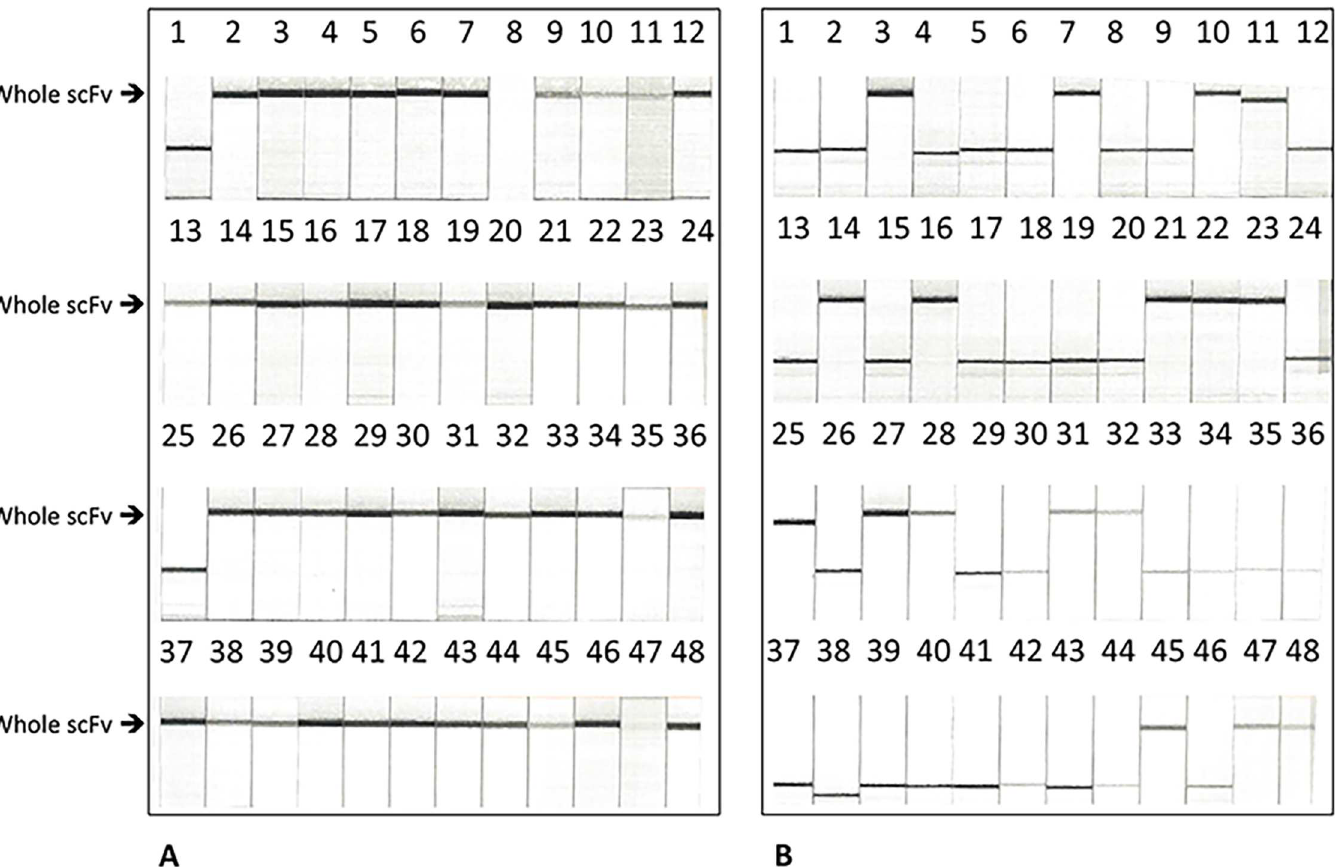
Fig 2. PCR analysisof scFv selectionsamplifiedwitheitherhelperphageor helpercells. Extensive characterizationof helpercells derived from various combinations of helperplasmidsand E . coli strains led us to choose those best suited for high transformation efficiency, high infectability and high phage-producing.Toward thorough characterizationof helpercells we furtherinvestigated their utilityfor scFv selection. The resultof the PCR and capillary electrophoresis analysisof representative numberof scFv clones are shown. The DNA encodingfull-lengthscFv correspond to the higherbands (about800 bp), whereasthe lower bands correspondto DNA encoding truncated scFv of differentsizes. After the second cycle of panning, libraryoutputs amplifiedwith eitherhelperphage (A) or with helpercells (B) containedapproximately 4% or 66% truncatedscFvs respectively. Thus, helpercells are intolerantof the scFv, leadingto truncations,and insteadare ideal for